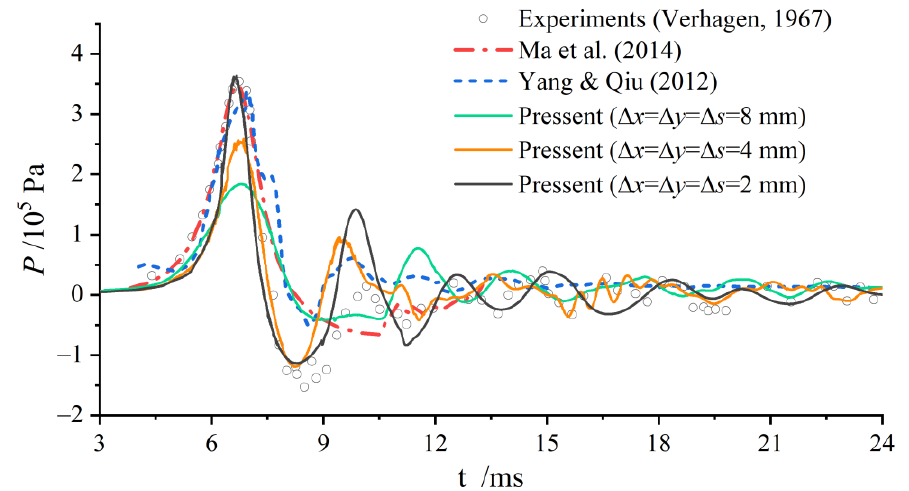
Figure 7. Slamming pressure in the bottom center of the plate [3,29,40].